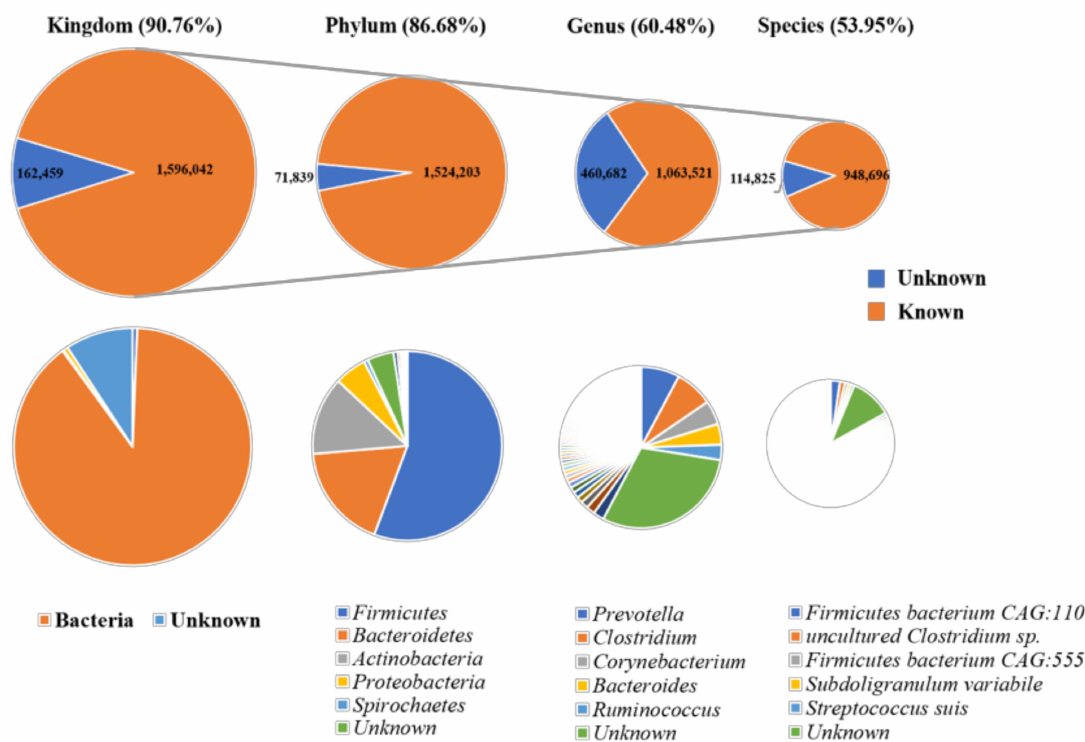
Figure 2. Taxonomical annotation of the bioaerosol catalogue to the kingdom, phylum, genus, and species